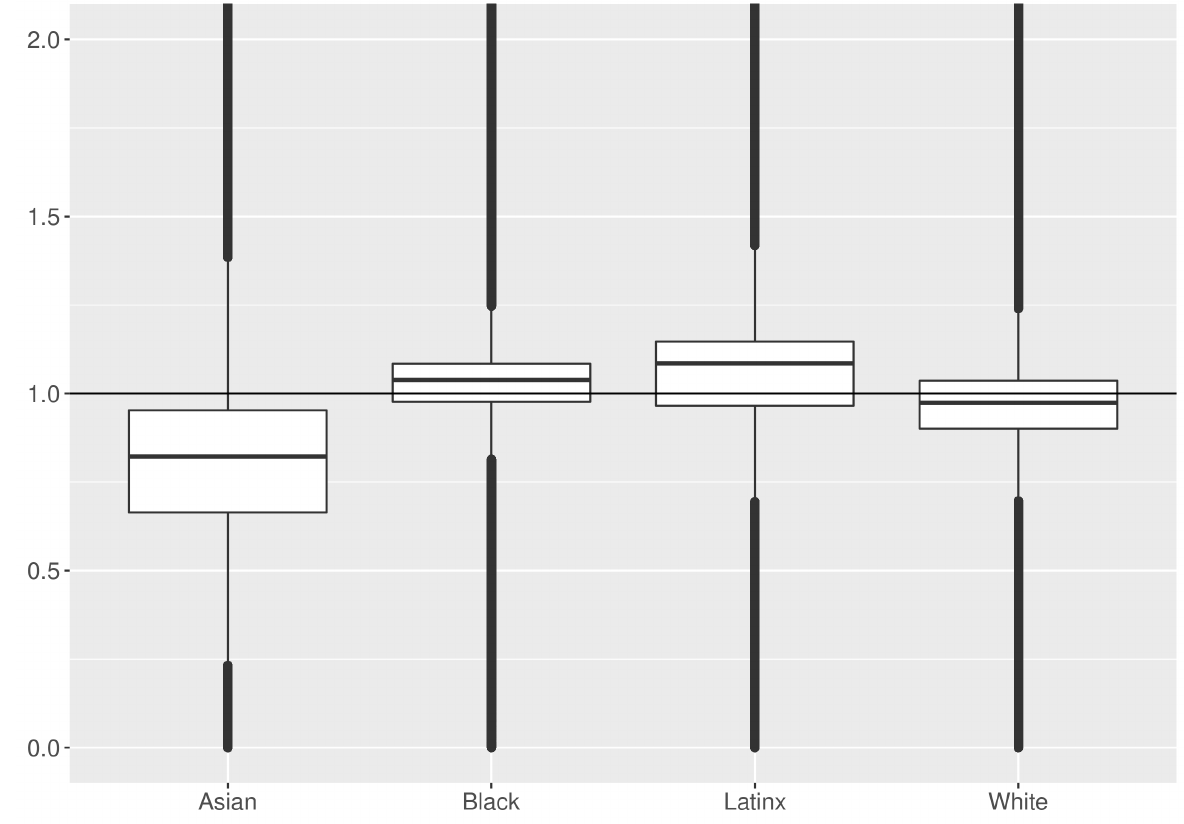
Figure 3: Distributions of female–male ratios of eviction rates by race/ethnicity. Note: Data are presented as box and whisker plots, displaying distributions through five statistics: the median (the horizontal line within the white box for each state), the 25th and 75th percentiles (which form, respectively, the lower and upper bounds of each box), and two whiskers. Whiskers extend no more than 1.5 times the interquartile range (the distance between the first and third quartiles). Rates beyond the range of the whiskers are considered outliers and are plotted as individual